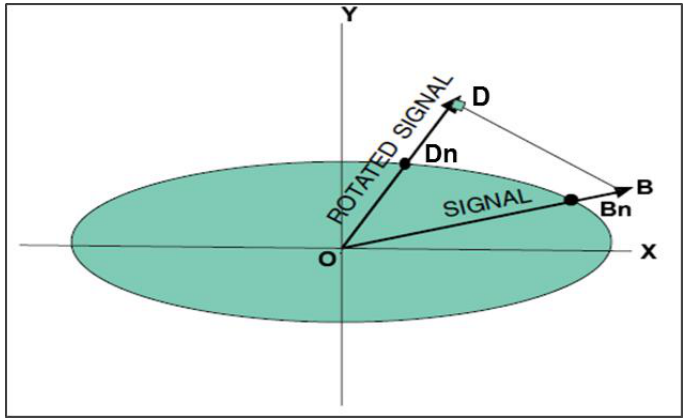
Figure 2. An illustration of the technique of optimal fingerprinting. The green horizontal plane represents the natural climate noise. The in-situ signal to noise ratio given by external forcing signal/ natural climate noise (OB/OBn) laying in the direction of the overwhelming natural climate noise. And the rotated signal to noise ratio new direction space/natural climate noise (OD/ODn) laying in the direction of minimized natural climate noise. The technique of optimal fingerprinting merely identifies the direction OD. Source: IPCC